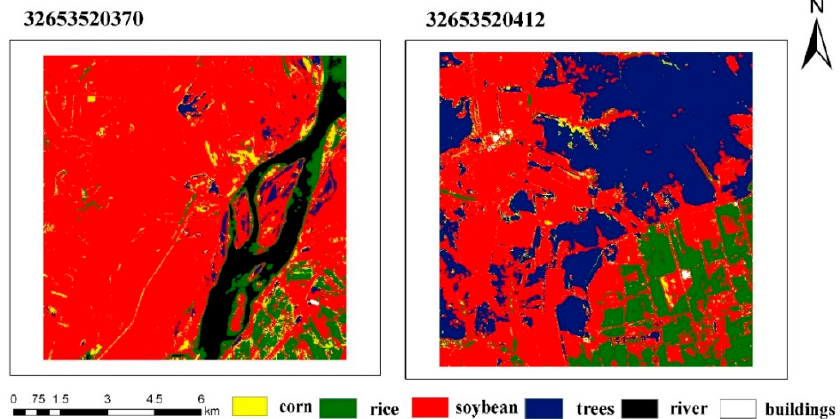
Figure 15. Classification results with trees, rivers, buildings, corn, rice and soybeans.